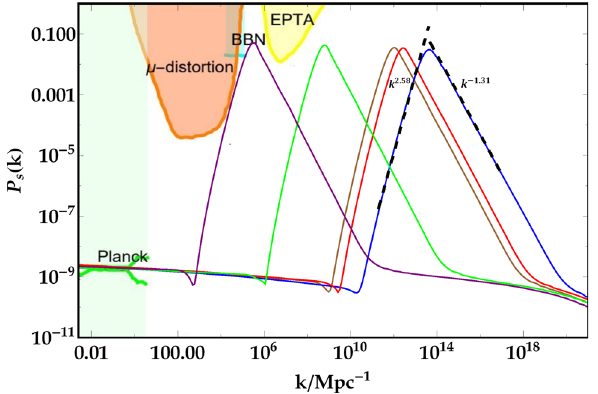
Fig. 3 The obtained exact scalar power spectrum via resolving the Mukhanov–Sasaki equation in terms of comowing wavenumber k . The purple,green,red,blue,andbrownlinesareaccordingtotheCasesA,B, C, D, and F respectively. The light-green shadowy zone represents the CMB observations [24]. The yellow, cyan, and orange shadowy zones represent the restrictions from the PTA observations [86], the effect on the ratio between neutron and proton during the big bang nucleosyn- thesis (BBN) [87], and the μ -distortion of CMB [88] respectively. The power-law form of P s with respect to k is illustrated by black dashed line for Case